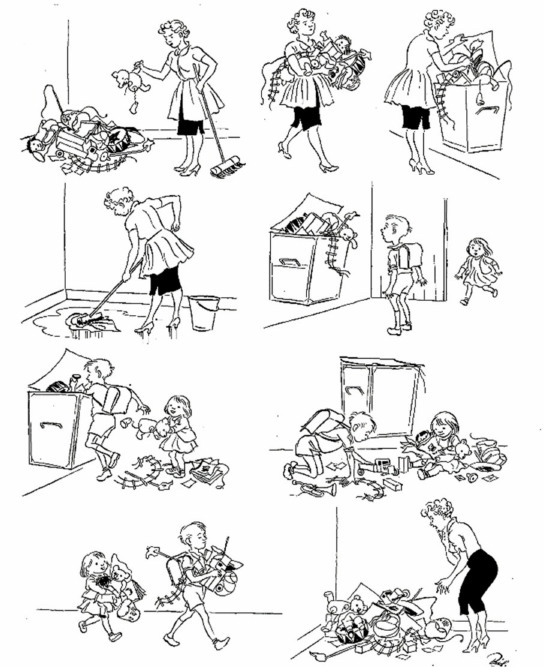
Figure 5. Example of stimulus material—a graphic story by Herluf Bidstrup. Each story was represented as a stack of separate cards in random